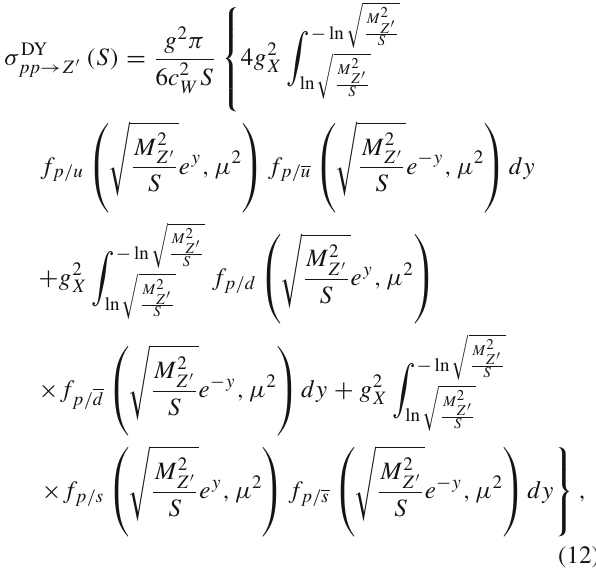
Fig. 3 The total Z (cid:2) production cross section via the DY mechanism at a future pp collider for the Z (cid:2)